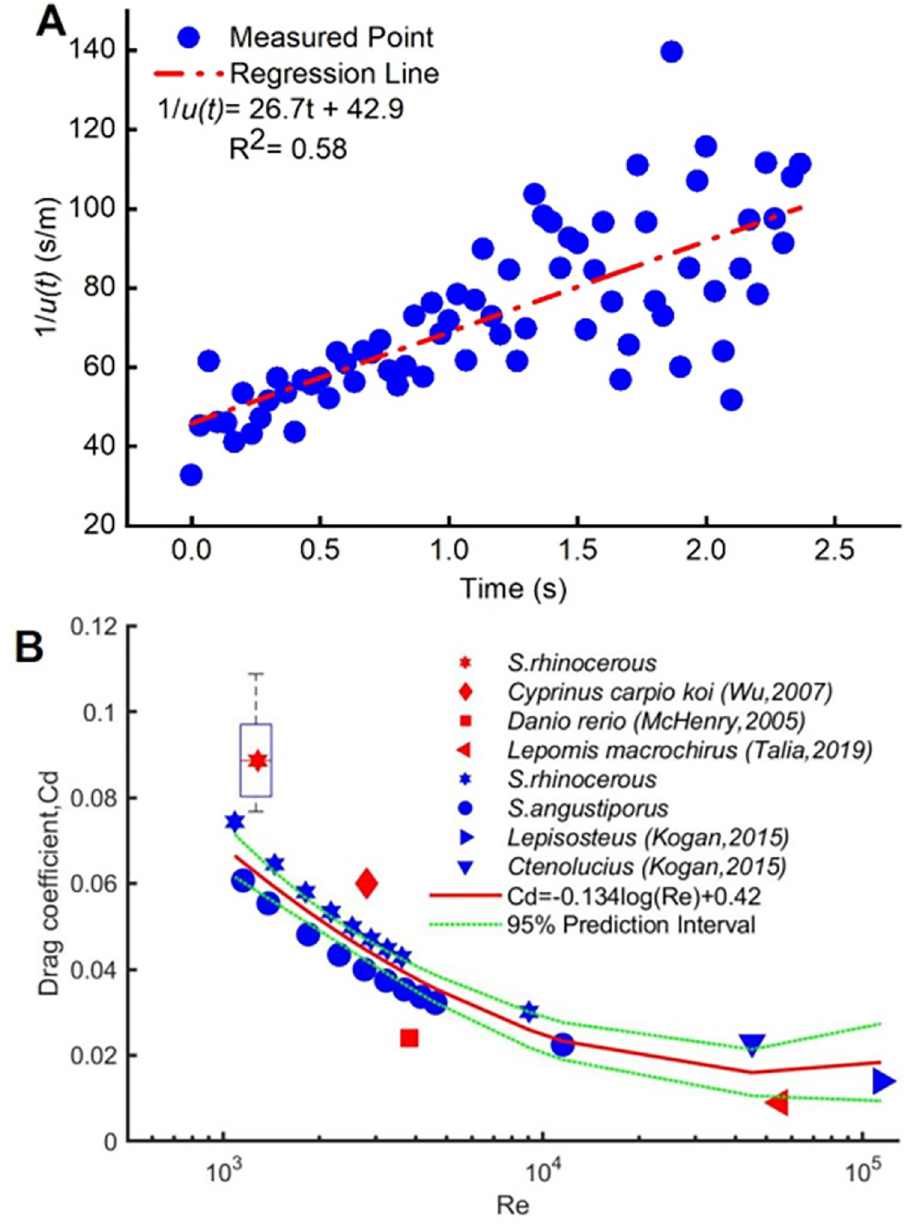
Fig 7. Drag coefficient estimation. (A) Reciprocal speed during the coasting phase of swimming; (B) Fish drag coefficient estimates obtained by measurements of swimming speeds (red) and by CFD modeling (blue) for analyses in this paper and reported by others. The red star indicates the median value derived for S . rhinocerous from Experiment 2, and the box delineates the 25 th and 75 th percentiles. The blue stars and circles are from the CFD simulations for S . rhinocerous and S . angustiporus , respectively. The red curve is a regressive fit to all the CFD results from this study. Fig 7A based on Eq 5 is 0.074. Using the 65 sequences from Experiment 2, Eq 5 yielded an esti- mate for the drag coefficient during the coasting phase C 7B, red star). For the same Re value (assumed for the experiment), the C obtained via Eq 7 from the CFD simulations for S . rhinocerous was generally consistent with that obtained from Experiment 2. The simulation estimate for C